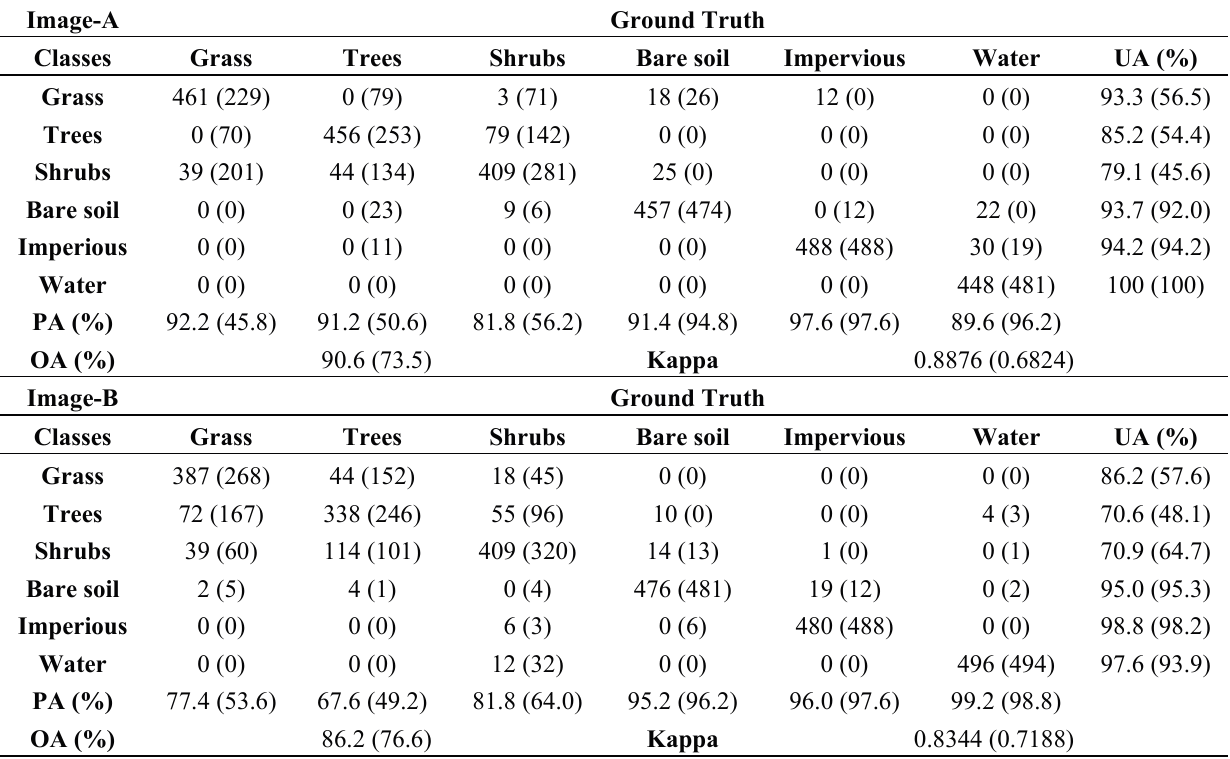
Table 1. Accuracy assessment of Random Forest with and without texture features.